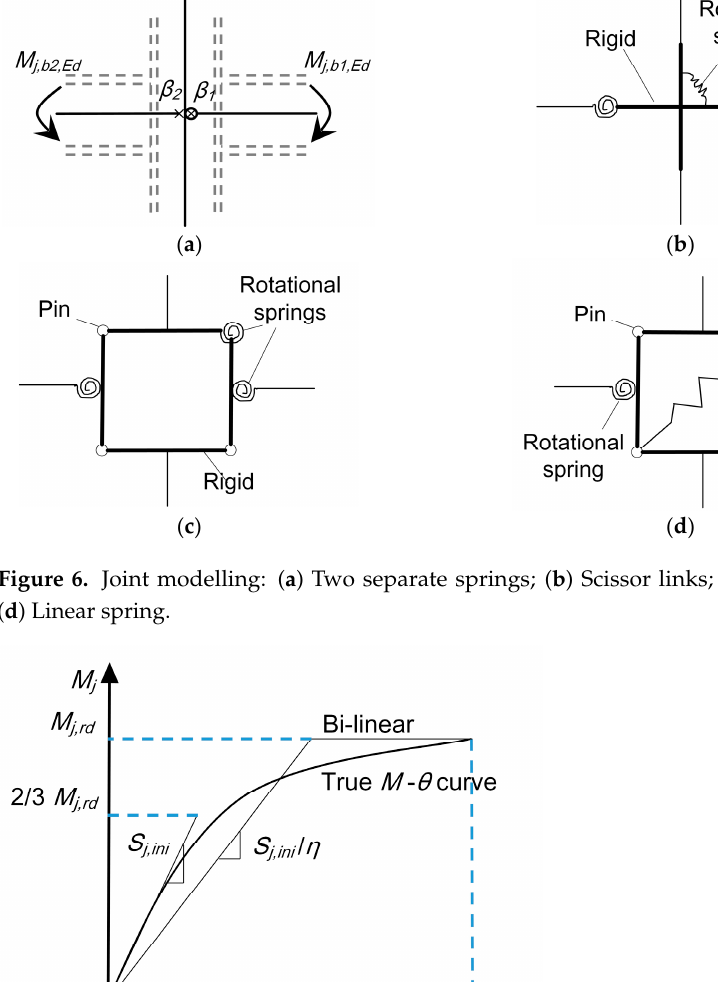
Figure 5. Joint (connection + web panel).